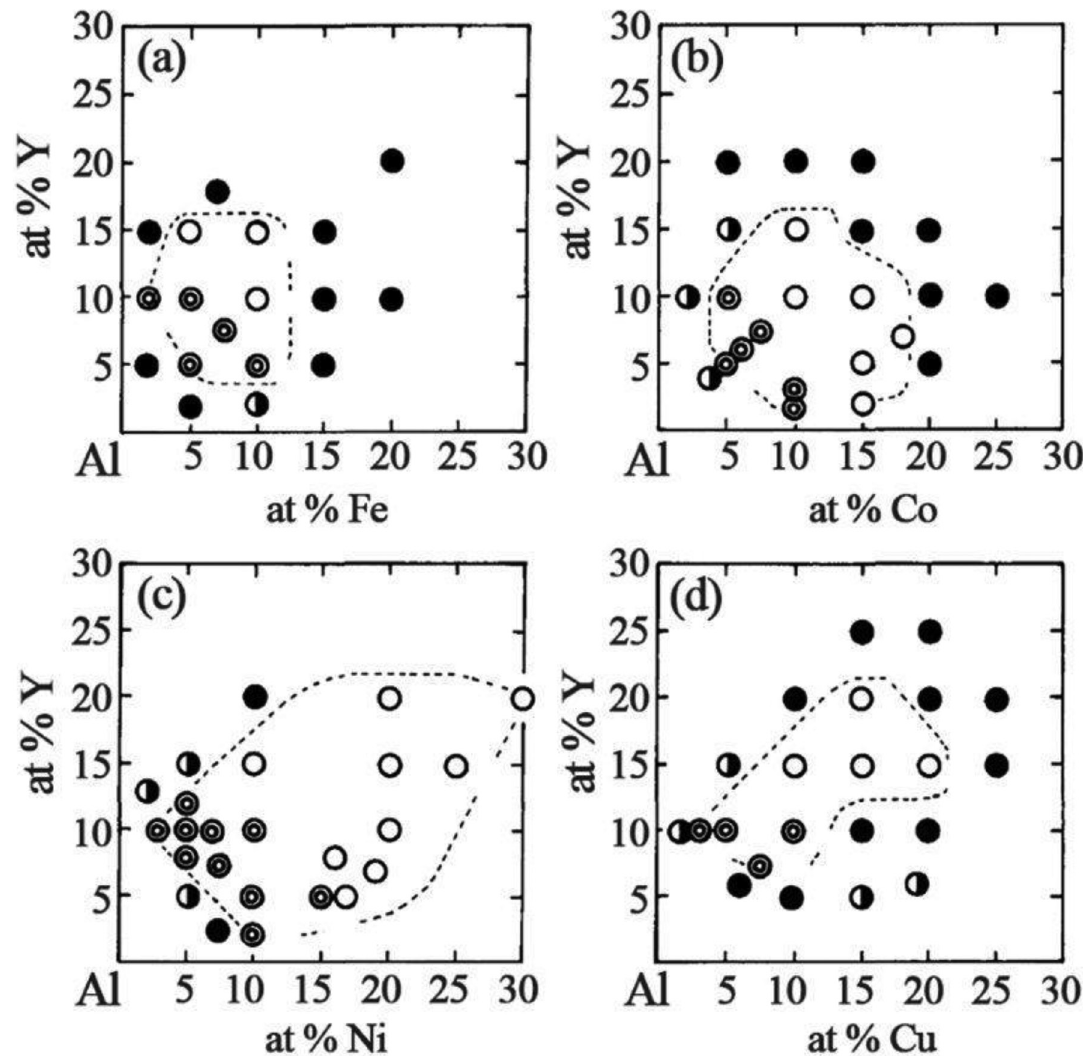
Figure 1. Compositional range for formation of amorphous phase in (a) Al-Y-Fe, (b) Al-Y-Co, (c) Al-Y-Ni and (d) Al-Y-Cu systems: (  ) amorphous (ductile); (○) amorphous (brittle); ( ) amorphous plus crystalline; (●) crystalline 3